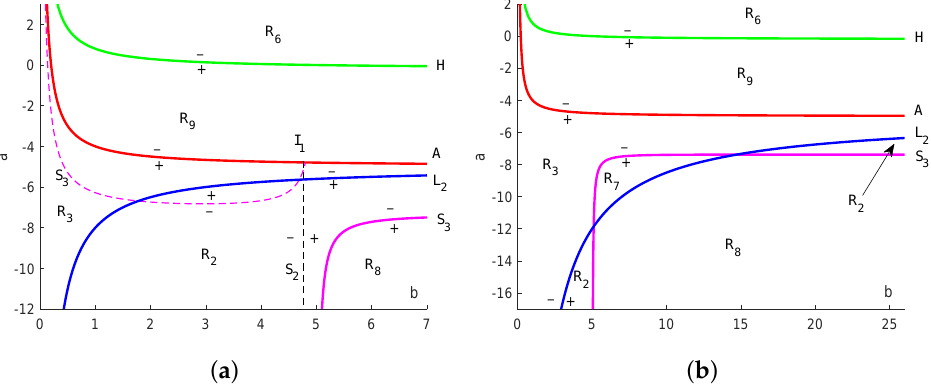
Figure 4. Bifurcation diagrams of the system (3) for m < 0, d > 0 and c > 1, ( a , b ). A region R 1 P 4 is an attractor is presented in ( b ).